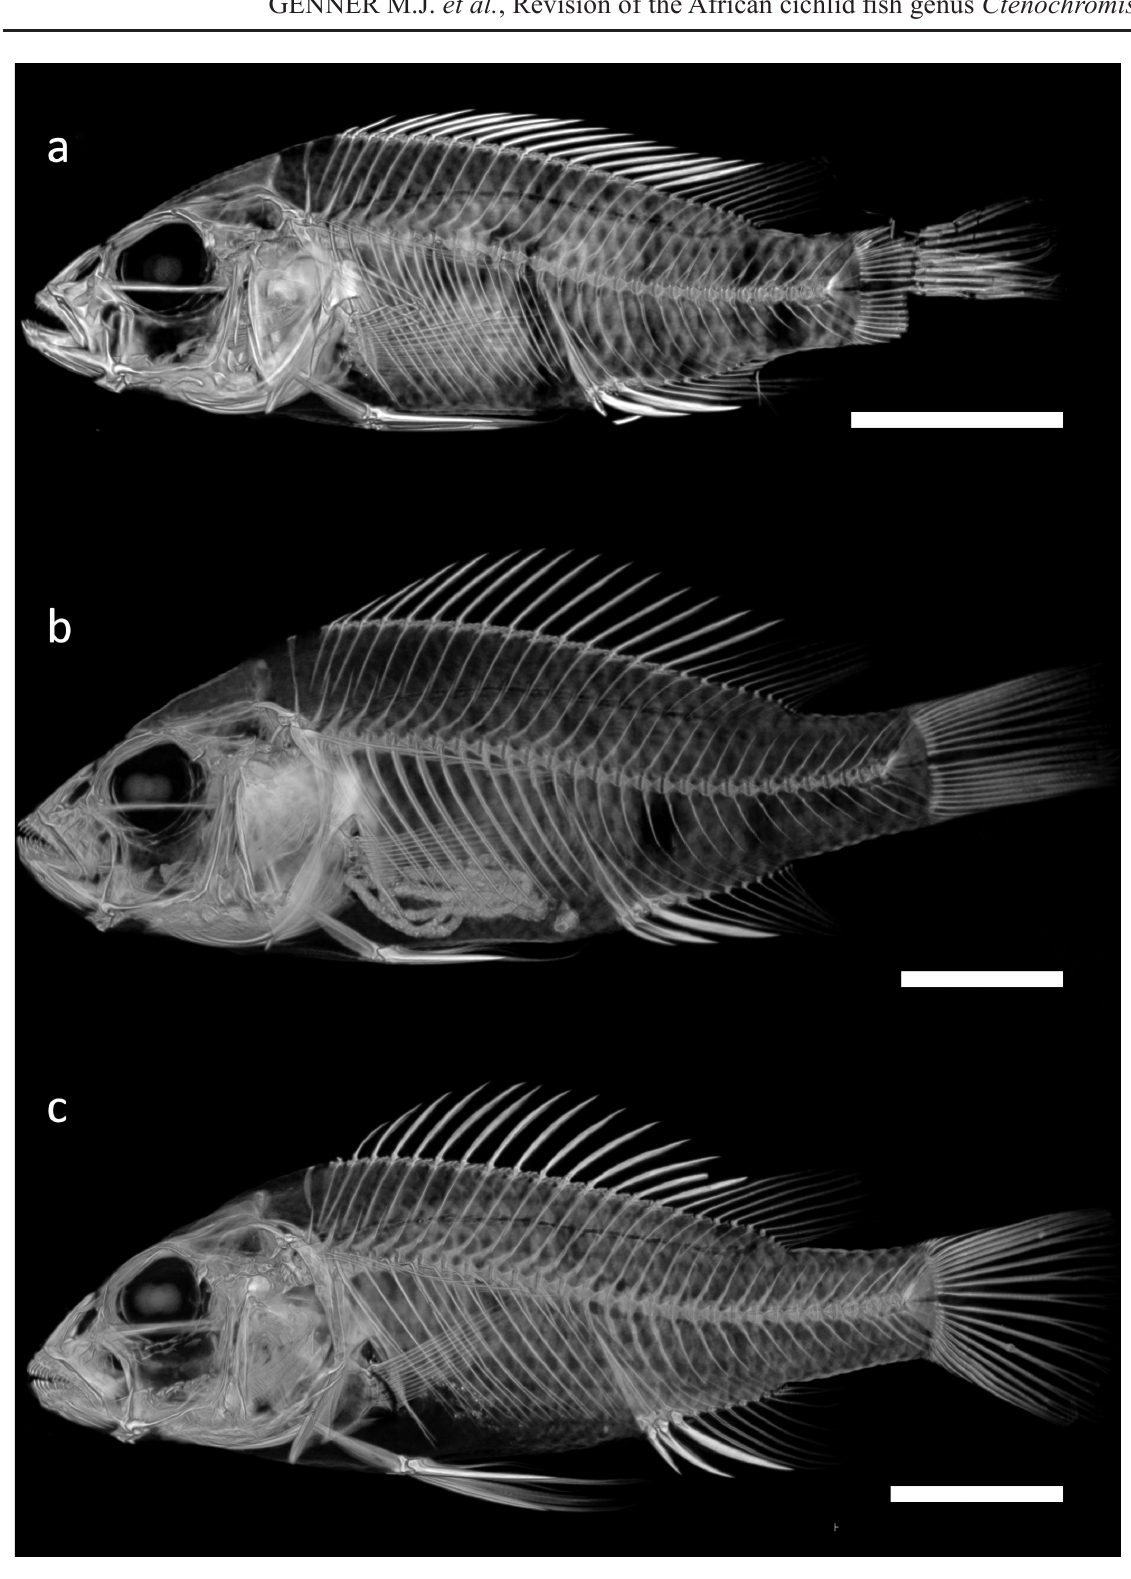
Fig. 8. Morphology of Ctenochromis Pfeffer, 1893, imaged using x-ray tomography micro CT. a . Ctenochomis pectoralis Pfeffer, 1893, paralectotype BMNH 1899.2.27.1 from Korogwe. b . C. pectoralis from the Ruvu River (part of BMNH 2021.7.15.1-3) . c . C. scatebra Genner, Ngatunga & Turner sp. nov., holotype BMNH 2021.7.15.4. Scale bars: 10